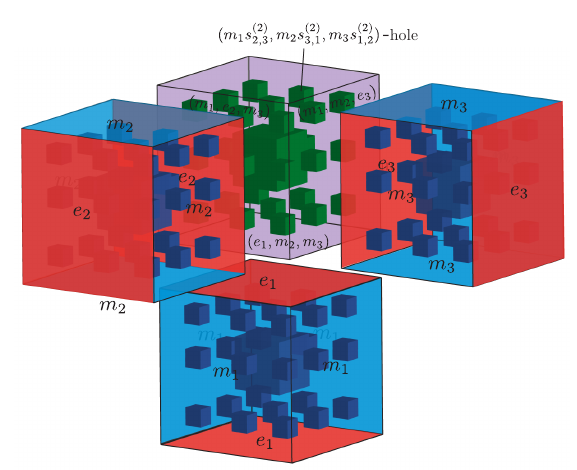
FIG. 33. The lattice surgery performed between the new cou- pled stack fractal code with three ancilla fractal codes along three directions in order to transfer the three logical qubits encoded in the coupled stack fractal code into the three ancilla code